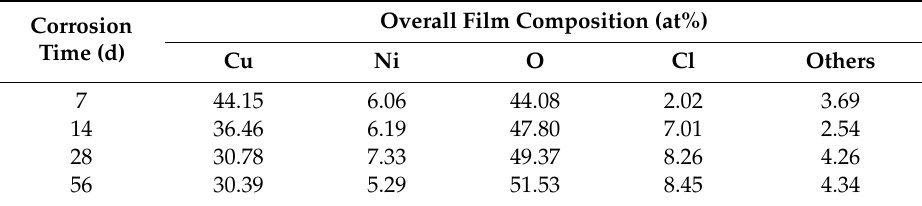
Figure 6. SEM micrographs of specimen surface after di ff erent corrosion time before ( a1 – a4 and b1 – b4 ) and after ( c1 – c4 ) removing corrosion products: ( a1 , b1 ) 7 d, ( a2 , b2 ) 14 d, ( a3 , b3 ) 28 d, ( a4 , b4 ) 56 d, ( b ) the magnified image of the white box in ( a ); ( c1 ) 7 d, ( c2 ) 14 d, ( c3 ) 28 d, ( c4 ) 56 d. Table 4. The EDS analysis of specimen surface composition in Figure